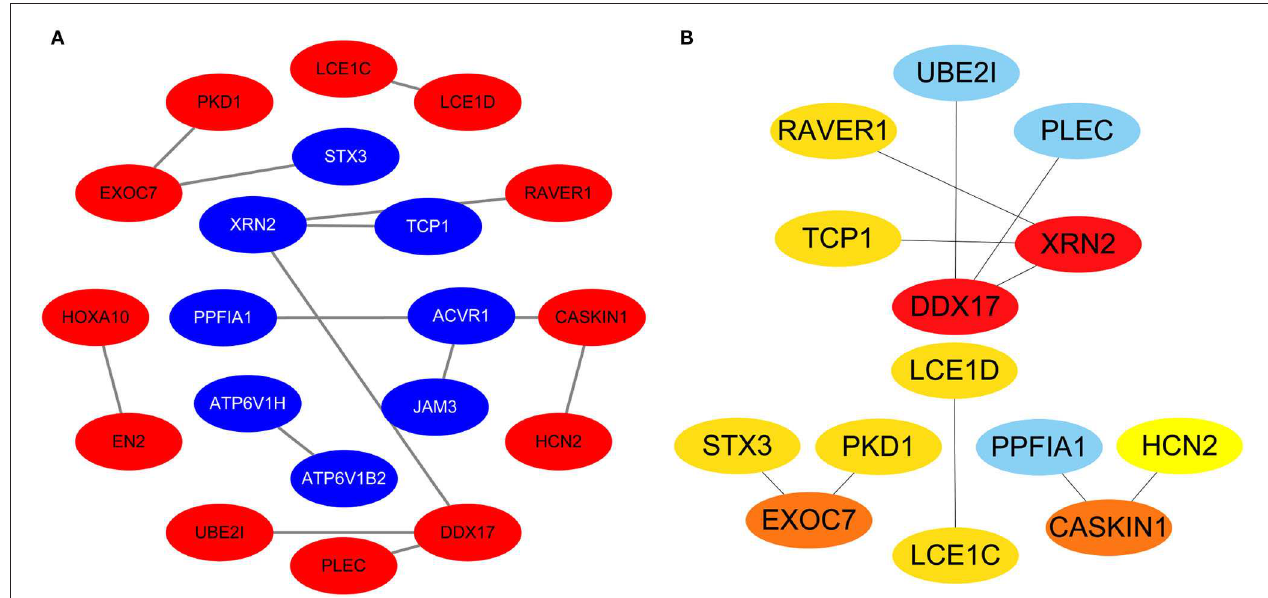
FIGURE 7 | Common PPI network. (A) Entire network. Downregulated and upregulated genes are represented by red and blue backgrounds, respectively. (B) Subnetwork for the top 10 hub genes and neighbors. The backgrounds of hub genes are colored from red to yellow by rank, and the backgrounds of neighboring genes are light blue. PPI, protein-protein interactions.